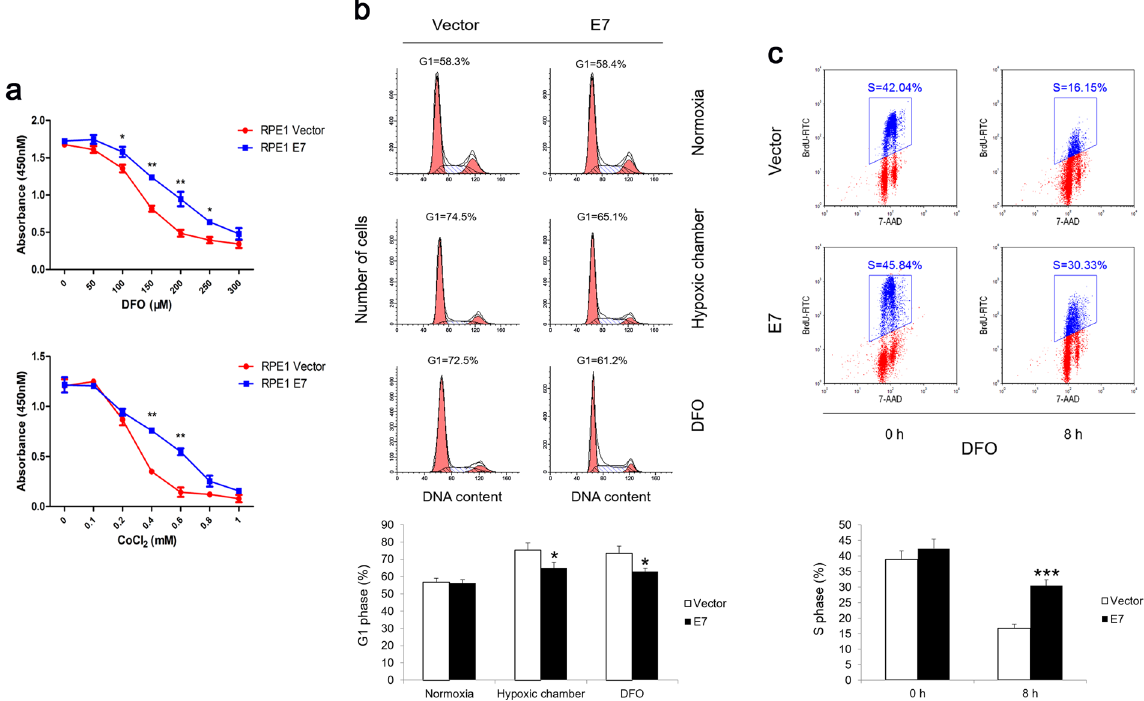
Figure 1. HPV-16 E7 abrogates hypoxia-induced G1 arrest. ( a ) RPE1 E7 cells were treated with hypoxia mimic drug DFO or CoCl 2 at different concentrations for 72 hours, cell viability was determined using CCK8 assay. Data from a representative of 3 experiments are shown. ( b ) RPE1 vector and RPE1 E7 cells were incubated in hypoxic chamber at 1% oxygen or with 200 μ M DFO for 8 hours, respectively. Cells were stained by PI and examined by flow cytometry. Data from a representative of 4 experiments are shown (Upper panel) and are summarized (Lower panel). ( c ) RPE1 vector and E7 expressing cells were treated with 200 μ M DFO for 6 hours and labeled with 20 nM BrdU for 2 additional hours. Cells were stained with anti-BrdU antibody, counterstained with 7-AAD, analyzed by flow cytometry. Data from a representative of 4 experiments are shown (Upper panel) and the percentage of BrdU-positive cells was gated. Data are summarized (Lower panel). Error bars reflected the standard error of the mean. * P < 0.05; ** P < 0.01; *** P <